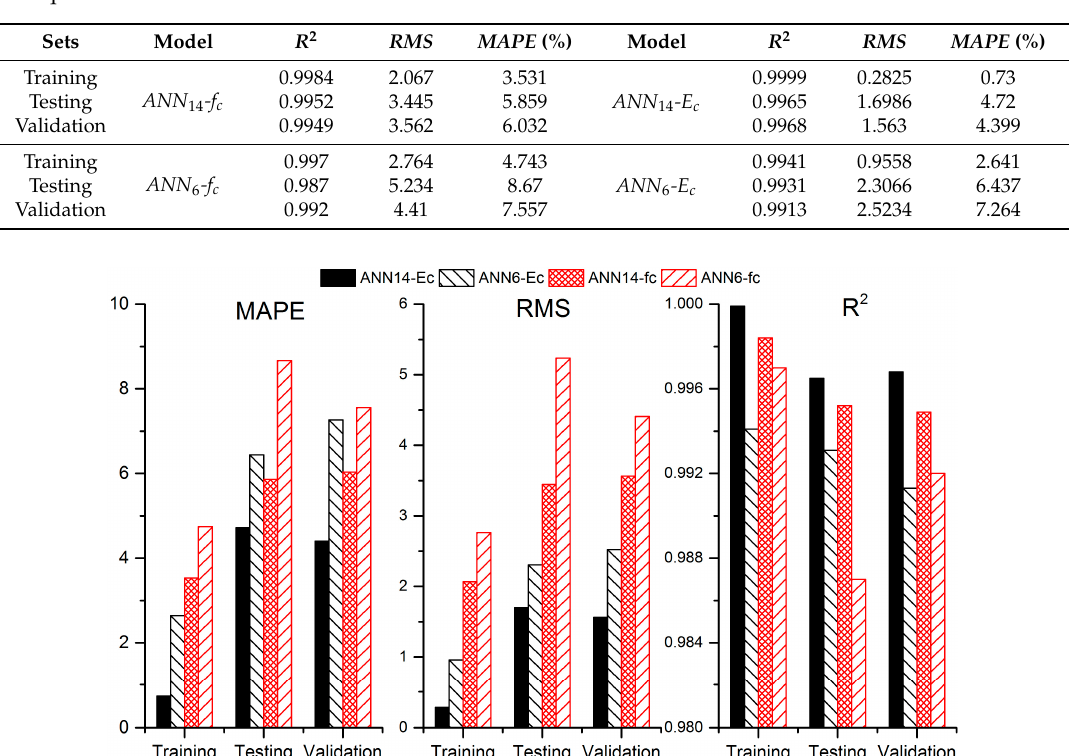
Figure 5. Performance of the ANN models constructed. MAPE : the mean absolute percentage error; RMS: root-mean-squared error.